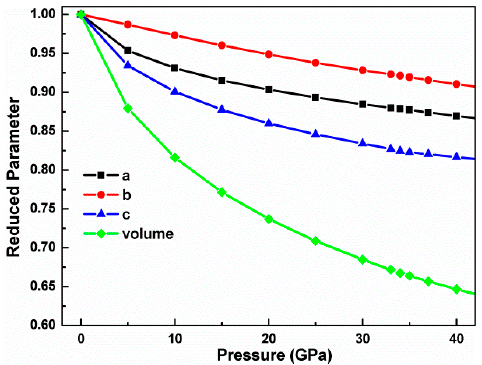
Figure 2. Dependence of the reduced crystal parameters of GeSe on the hydrostatic pressure.